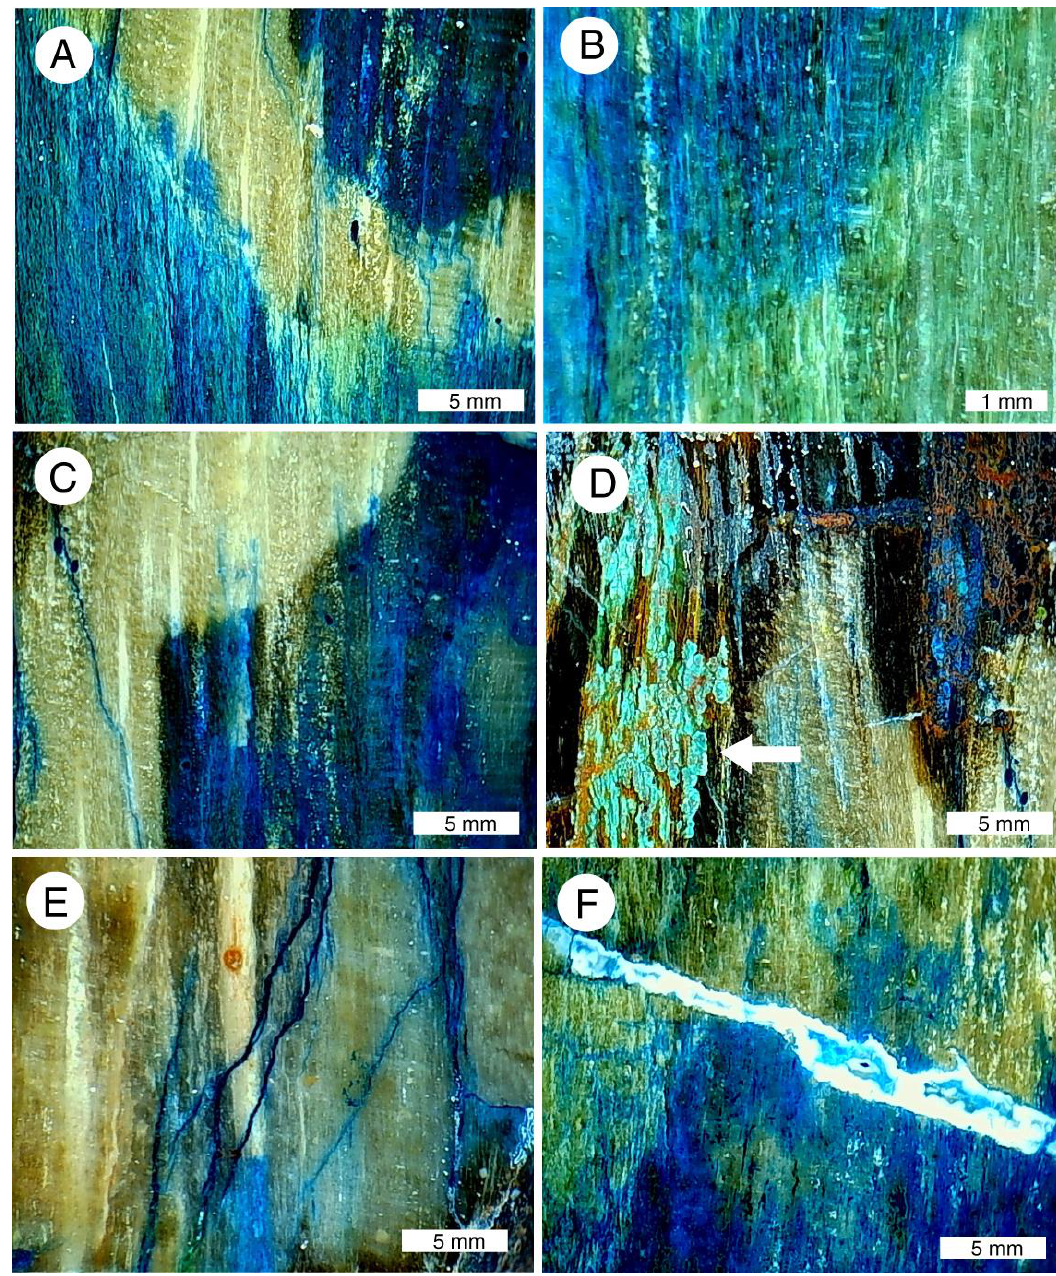
Figure 23. Low-power magnified views of “colla wood”. ( A – C ) Images show vivid color patterns caused by diffuse infiltration of copper minerals into silicified tissue; ( D ) chryscolla, marked with arrow, is a minor constituent; most coloration is due to malachite (green) and azurite (blue); ( E ) azurite was deposited by fluids moving through fractures in silicified wood; ( F ) copper-stained chalcedony fills fracture that cross-cuts wood grain.